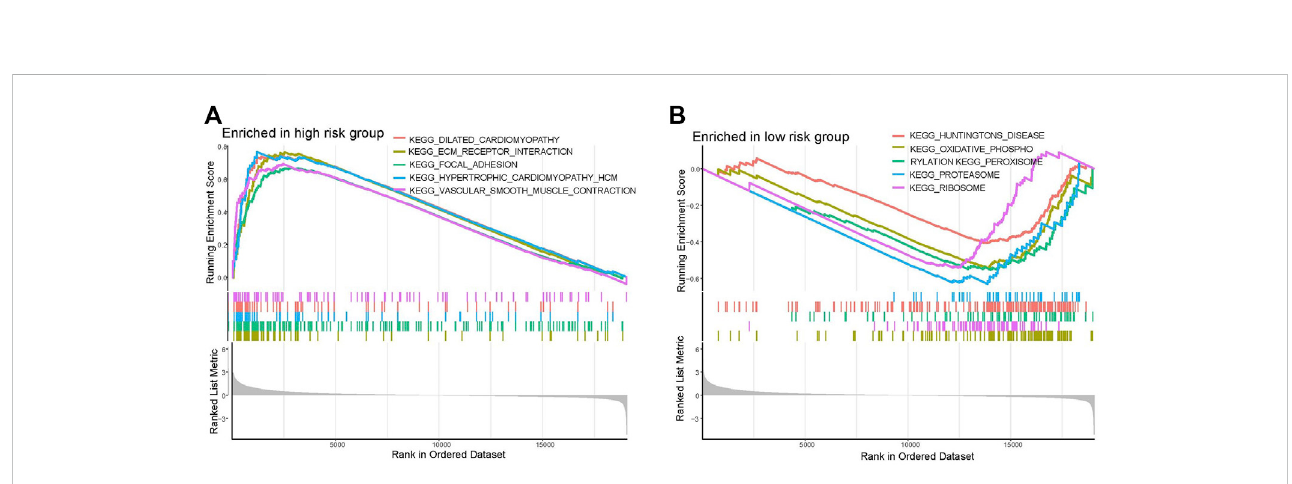
FIGURE 7 Gene set enrichment analysis in (A) high-risk and (B) low-risk